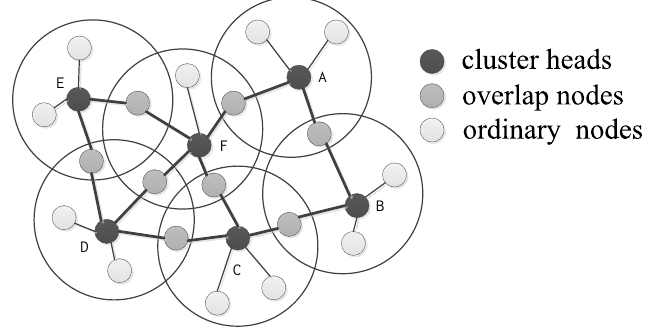
Figure 1. Overlapping cluster-based topology of Industrial Wireless Sensor Networks